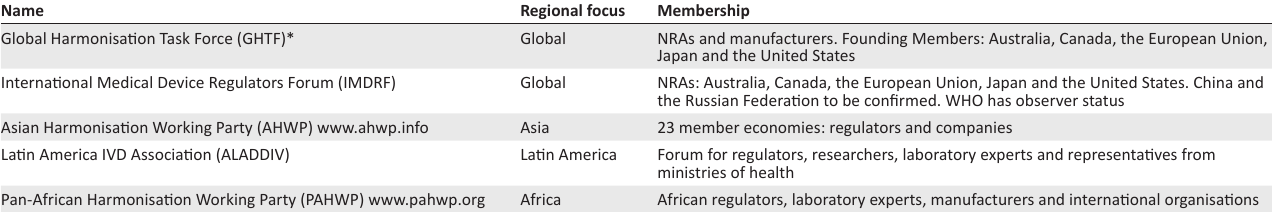
TABLE 2: Organisations promoting regulatory harmonisation of medical devices or in vitro diagnostics.